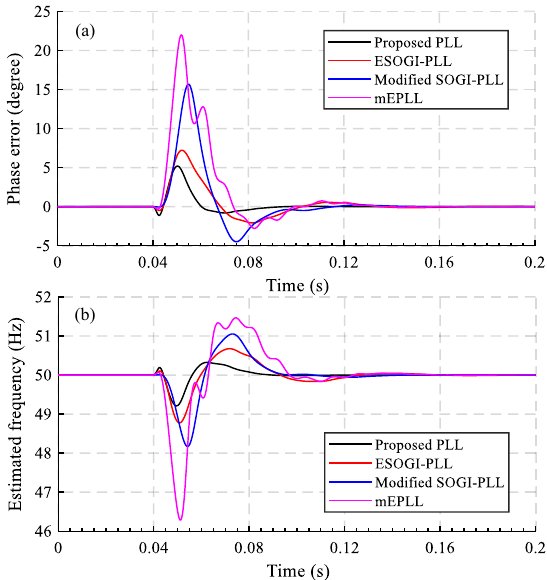
Fig. 12 Performance comparison between the proposed PLL, ESOGI-PLL, modified SOGI-PLL, and mEPLL under Case 6 (grid voltage amplitude reduced by 0.2 pu with a 0.15 pu DC offset added to the grid voltage at 0.04 s). a Estimated phase error and b estimated